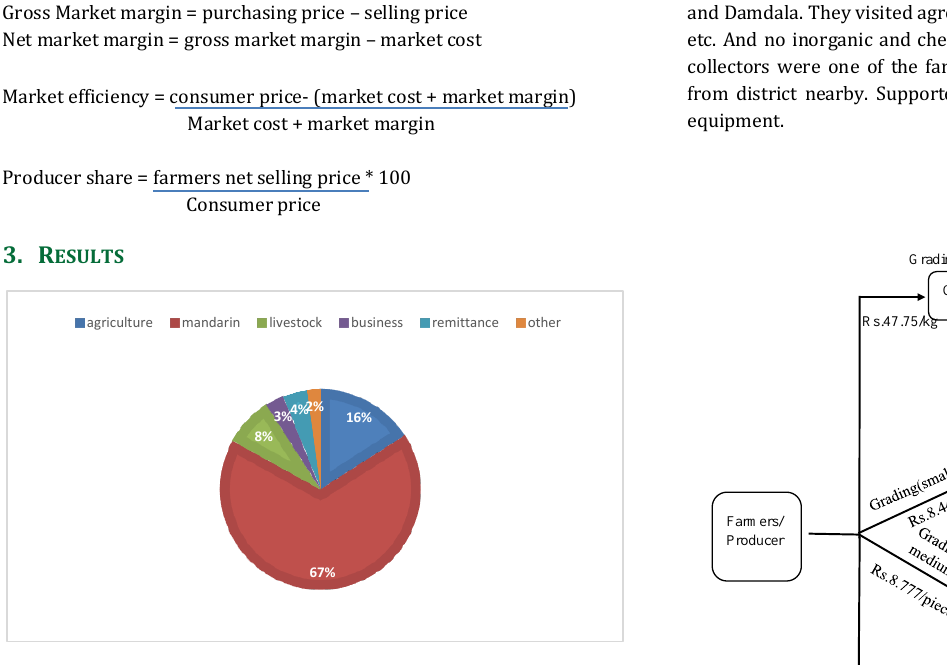
Figure 1: Source of income of respondents